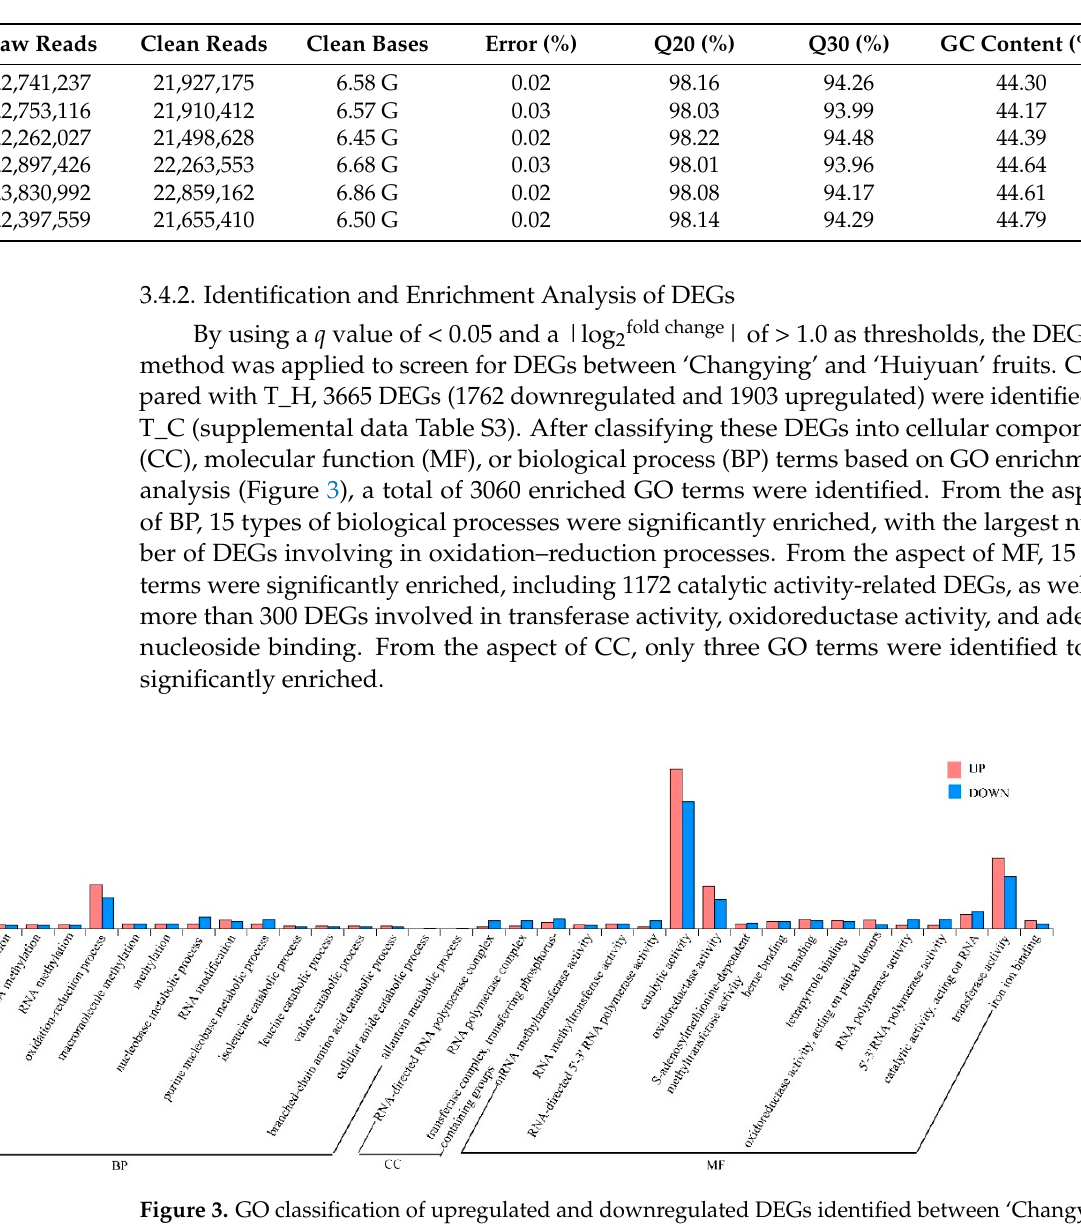
Table 2. Quality analysis of RNA sequencing data for the ‘Changying’ (T_C) and ‘Huiyuan’ (T_H) cultivars.